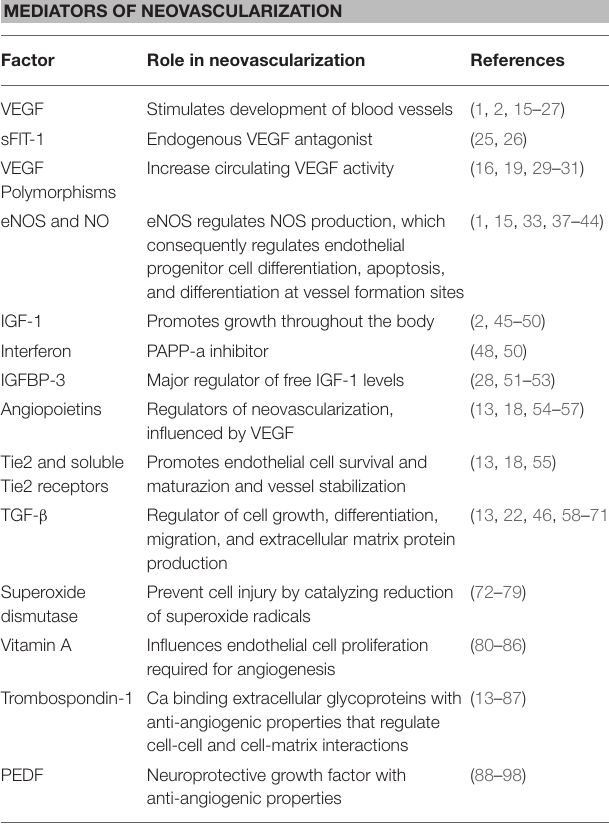
TABLE 1 | List of vascular factors common to BPD and ROP discussed in this